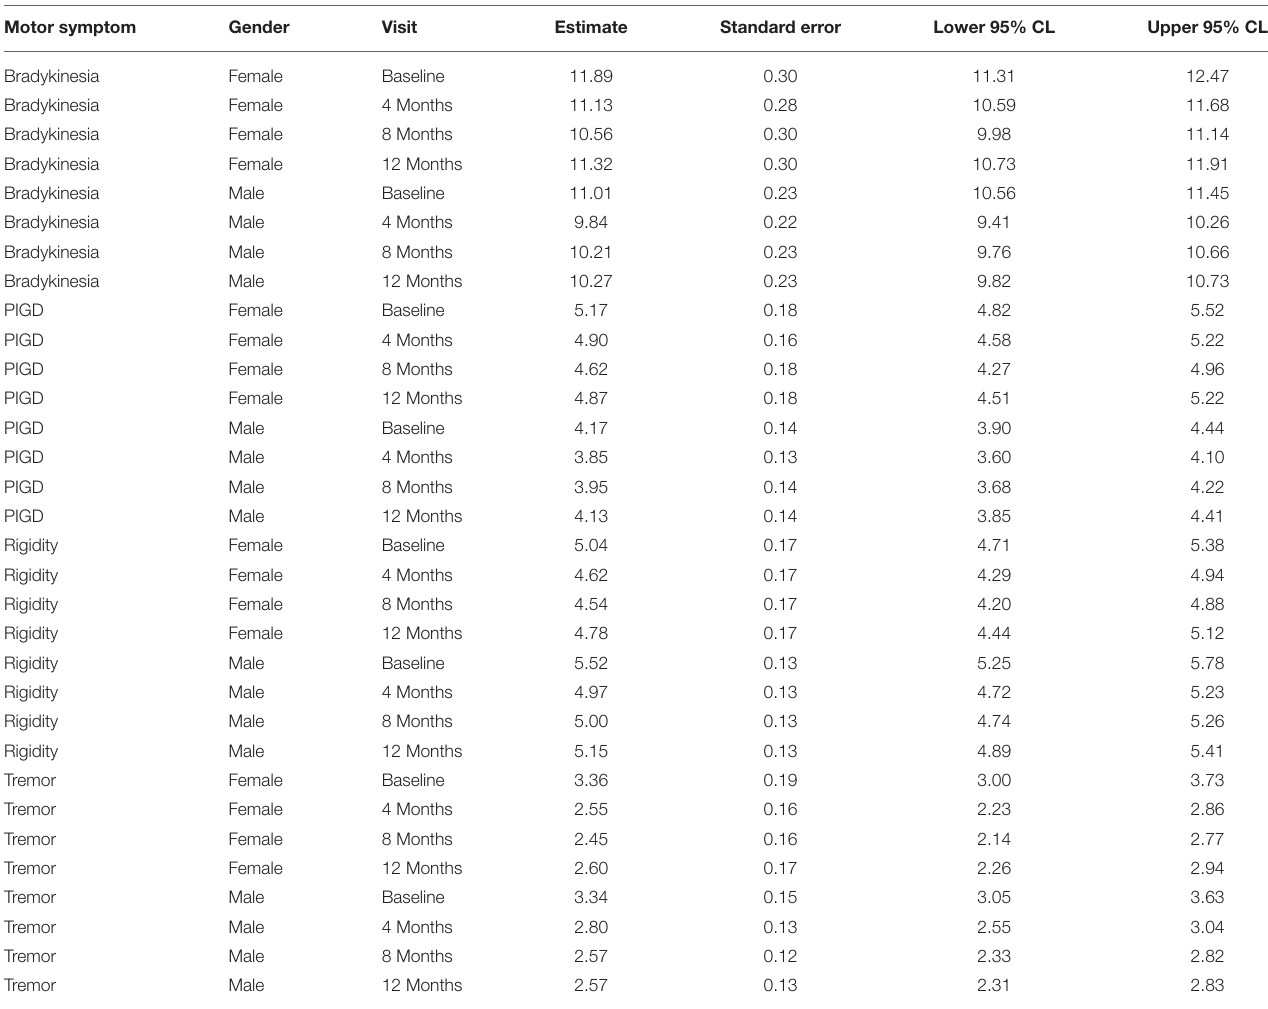
TABLE 3 | Descriptive statistics of cardinal motor symptoms grouped for gender and